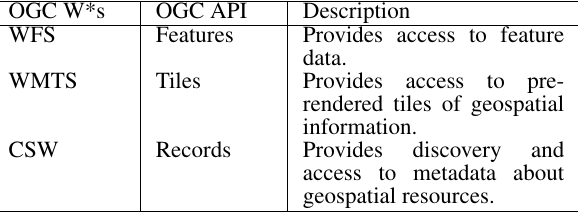
Table 1. Comparison of OGC API over OGC Web Service standards